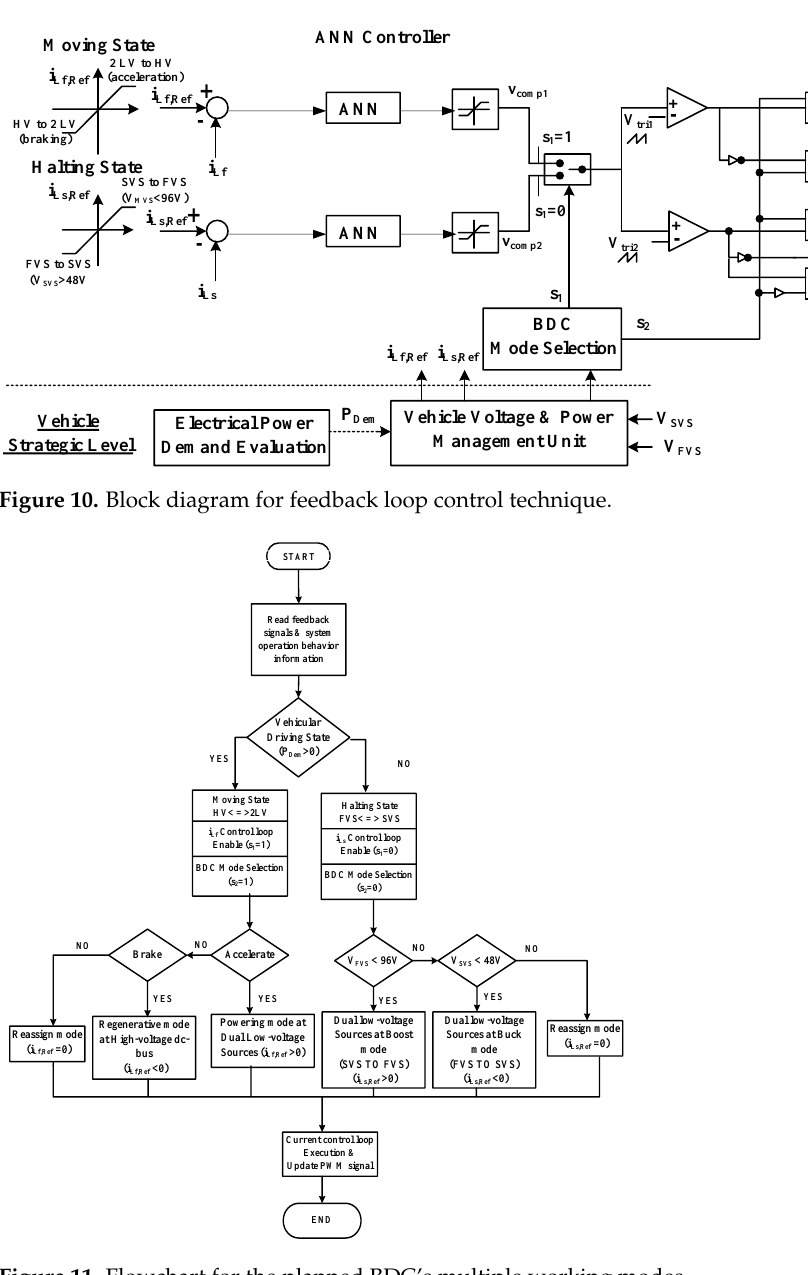
( a ) ( b ) Figure 12. ( a ). Switching mechanism of ANN controller. ( b ). Euclidean distance ANN method.